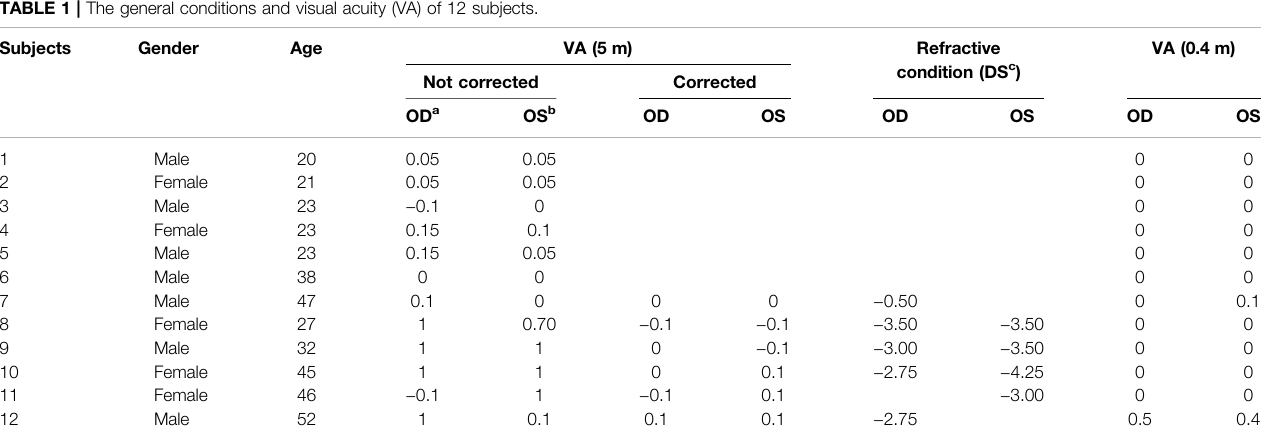
TABLE 1 | The general conditions and visual acuity (VA) of 12 subjects.